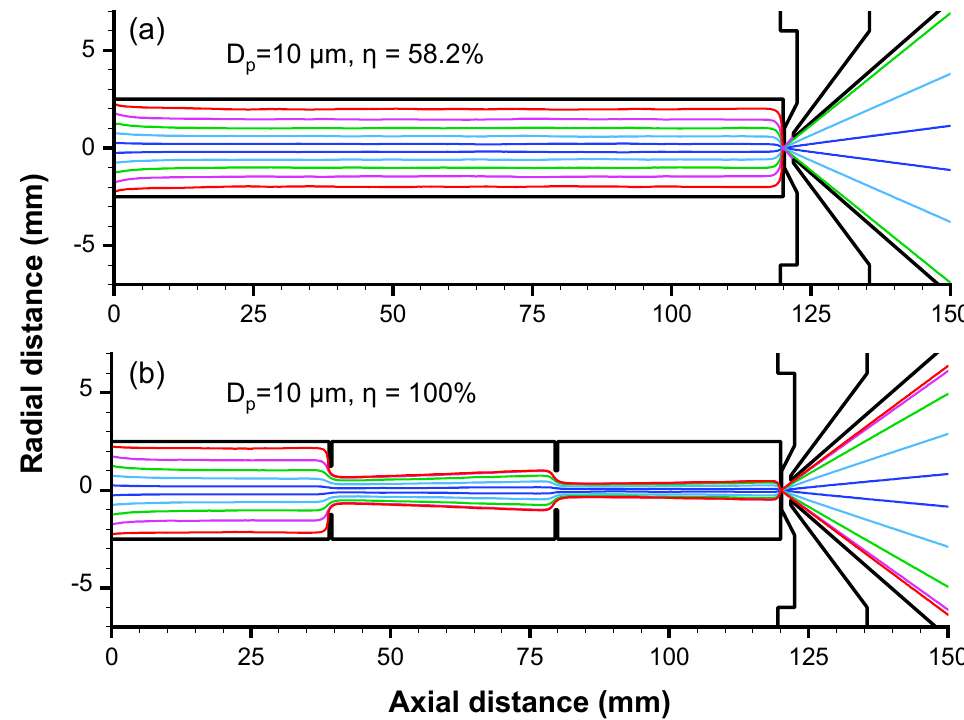
Figure 2. Simulation of the transmission trajectories of 10 µm PM without ( a ) and with ( b ) the pre-focusing inlet ports. The colors represent the trajectory of the particles at different locations.